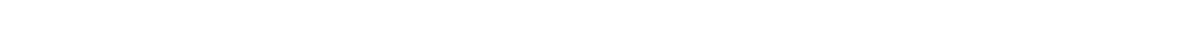
TABLE 2 | Main chemical components of iron tailings powder (%). Chemical